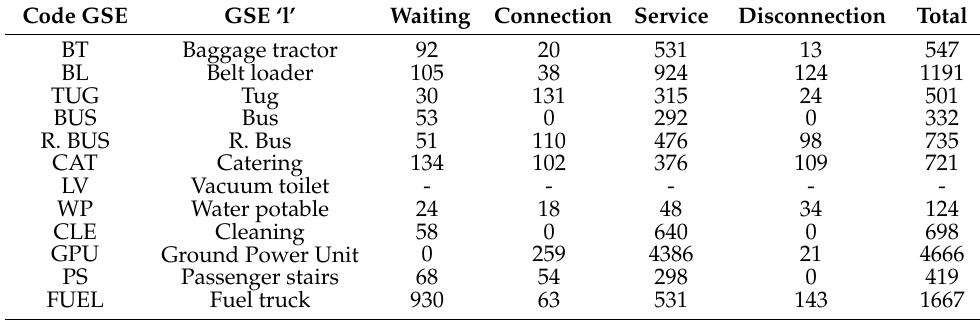
Table 2. Average duration for GSE according to measured times in seconds. Code